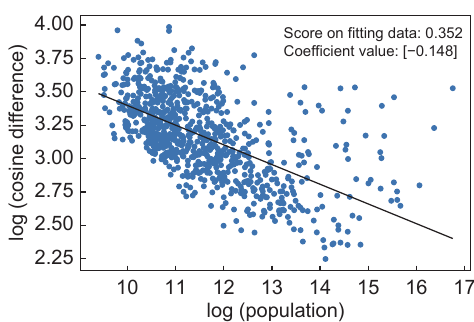
Fig. 10 log-log plot of the cosine distances between the vectors for MSAs and the center of mass for job